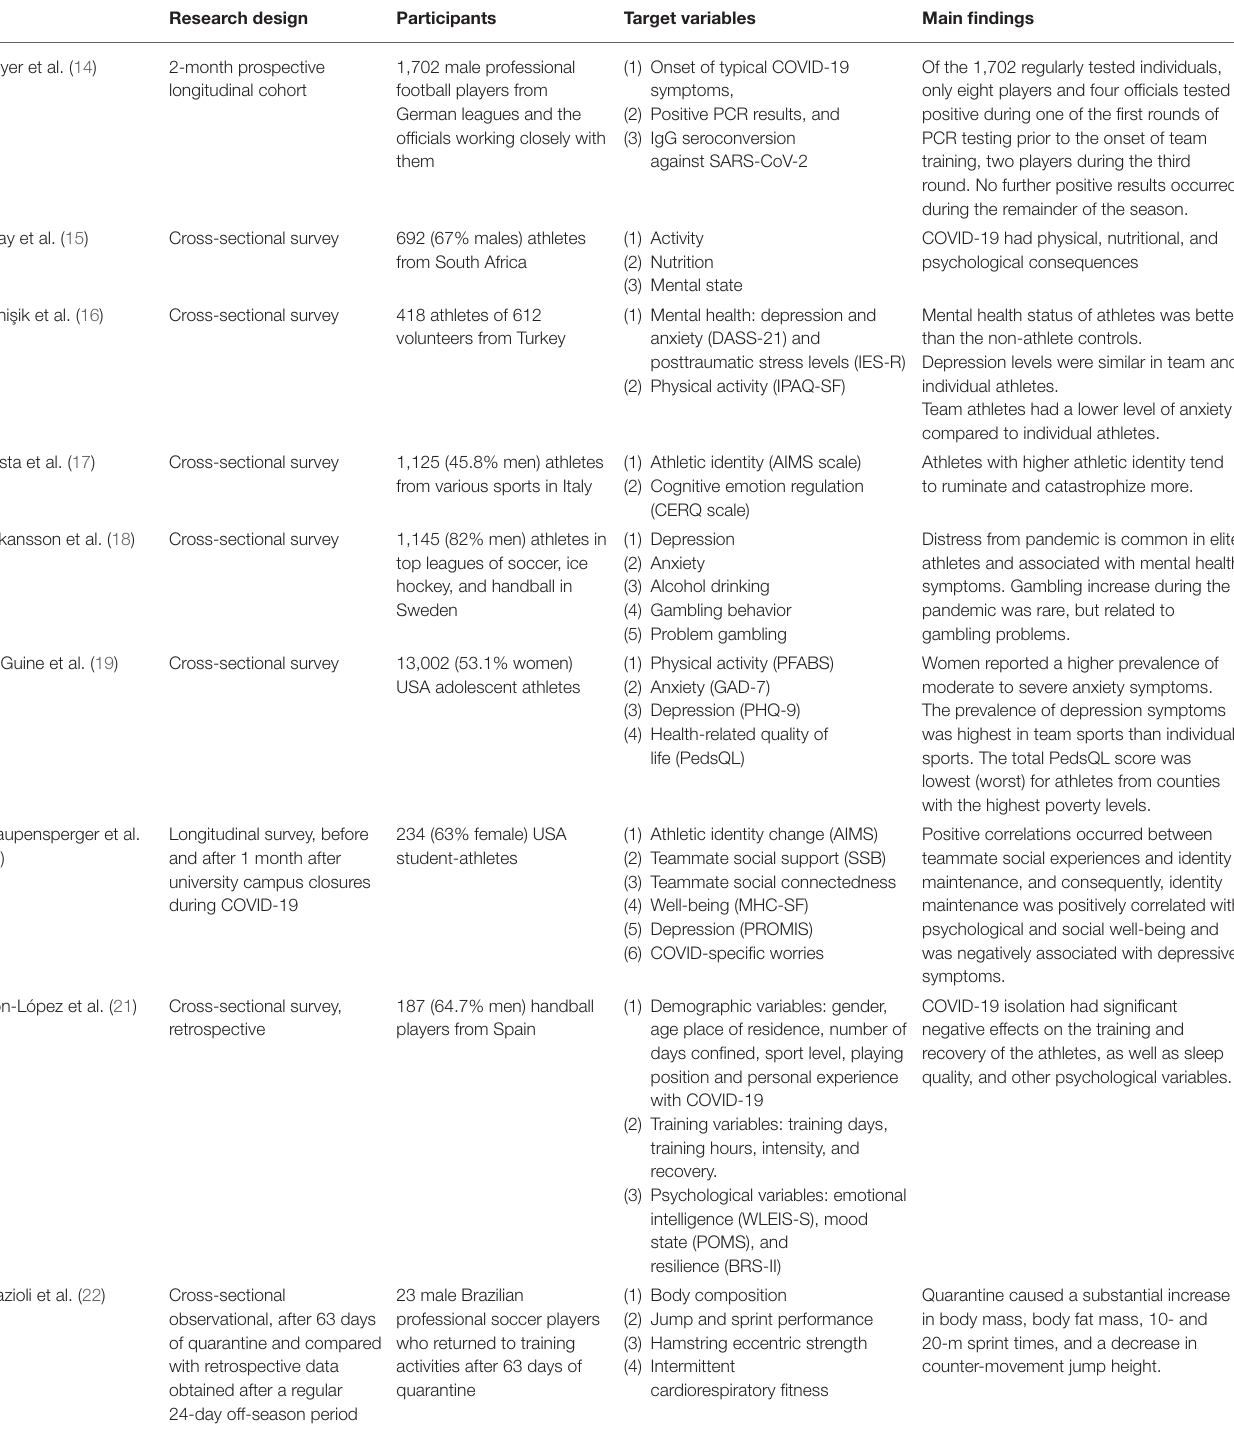
TABLE 1 | Original studies reporting on the impact of the pandemic on professional